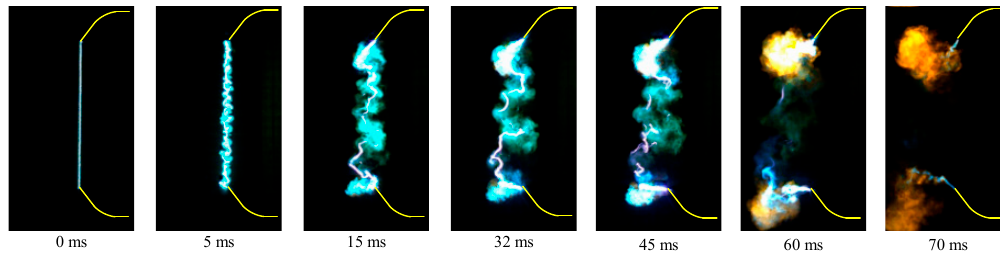
Figure 5. Development process of long free burning arc ( L gap = 1000 mm).